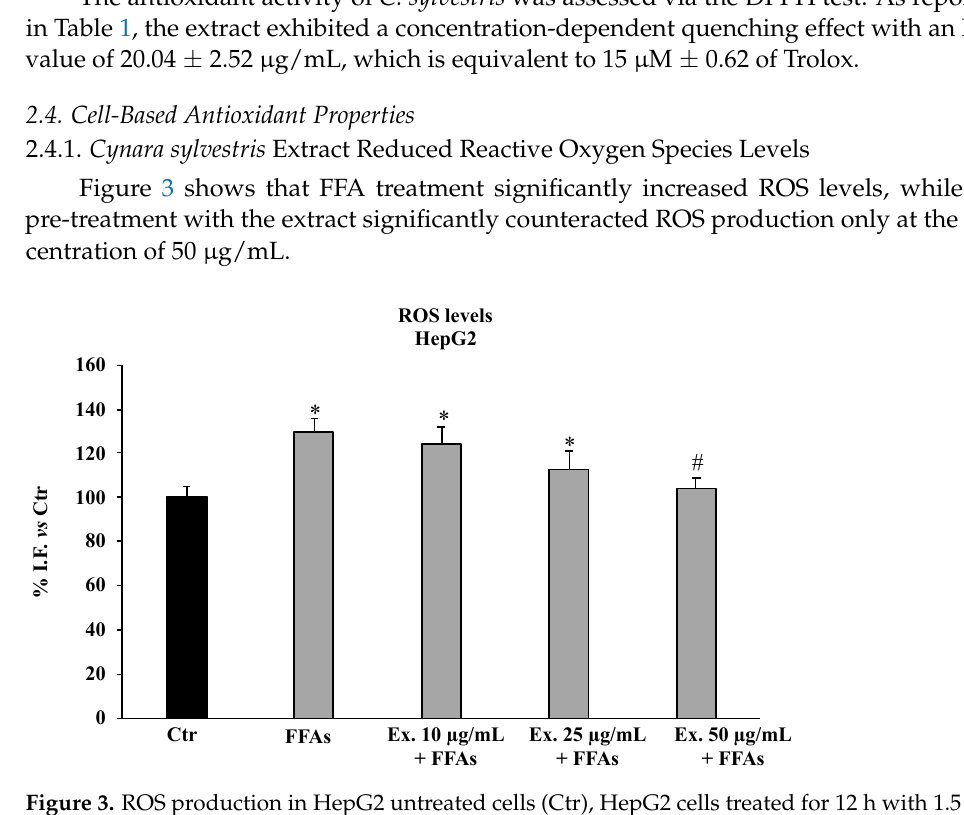
Figure 3. ROS production in HepG2 untreated cells (Ctr), HepG2 cells treated for 12 h with 1.5 mM FFAs 1, and HepG2 cells pre-treated with the extract (10–25–50 µg/mL) and exposed to FFAs 1. Results are expressed as percentage of intensity of fluorescence (I.F.)/mg protein vs. Ctr. Values are the mean ± S.D. of three independent experiments in triplicate. * Significant vs. untreated control cells: p < 0.001. # Significant vs. FFAs treated cells: p < 0.001.